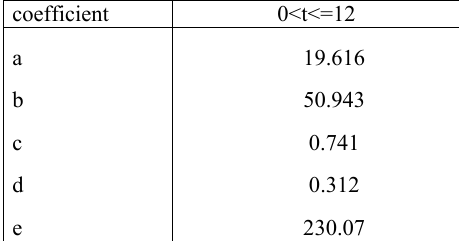
Table 1. Regression coefficients of clear brightness temperature